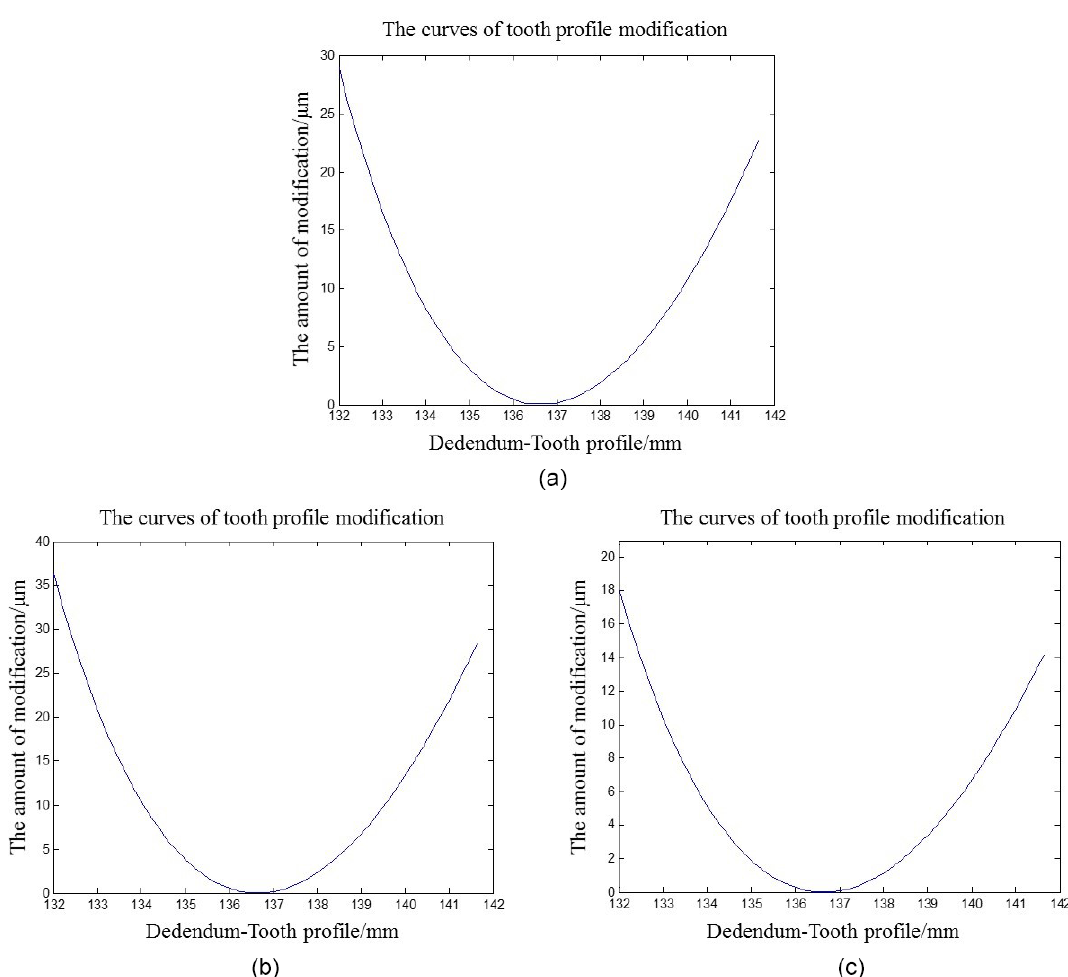
Figure 21. The three different tooth profile modification curves. (a) Maximum amount of theoretical modification at 28.5µm. (b) Maximum amount of modification at 37µm. (c) Maximum amount of modification at